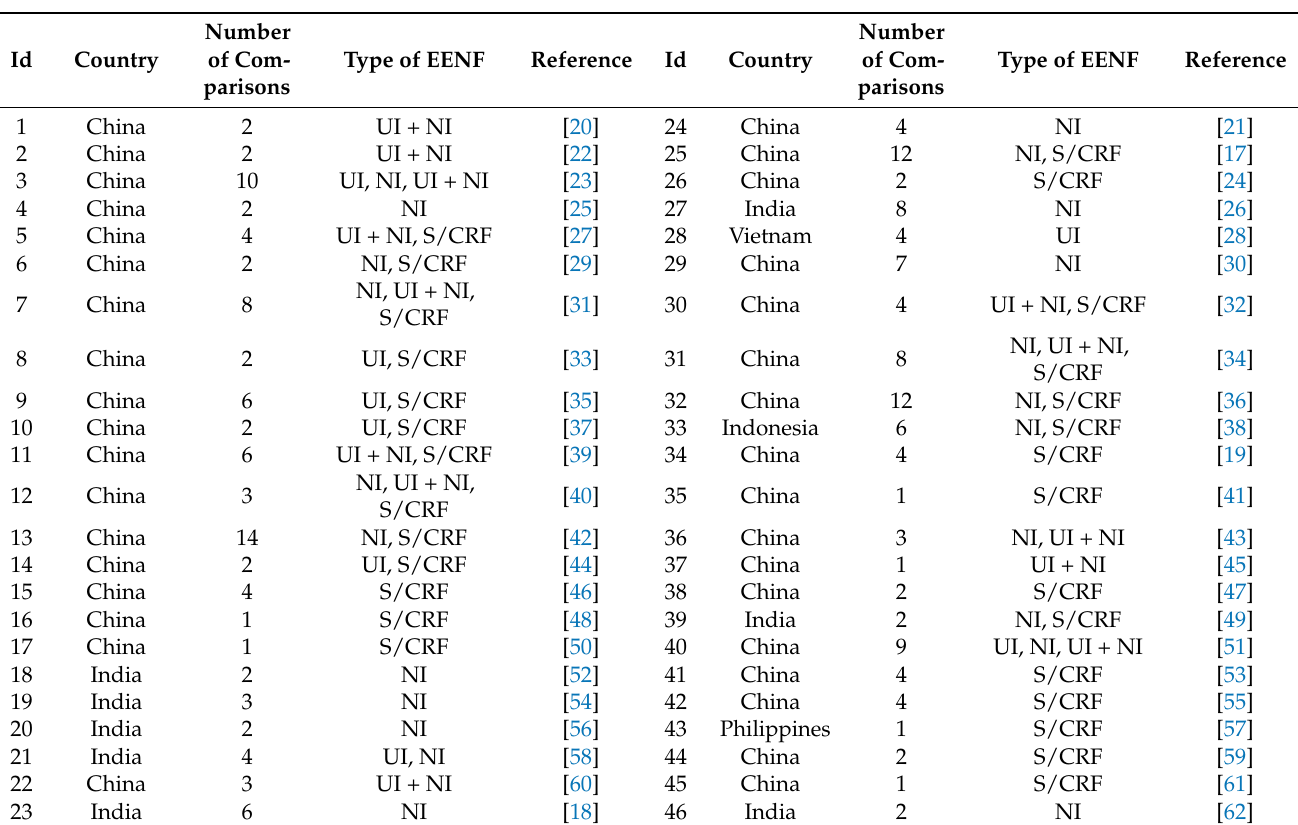
Table 1. The studies used in the meta-analysis to evaluate the impacts of EENF on CH 4 emission and rice